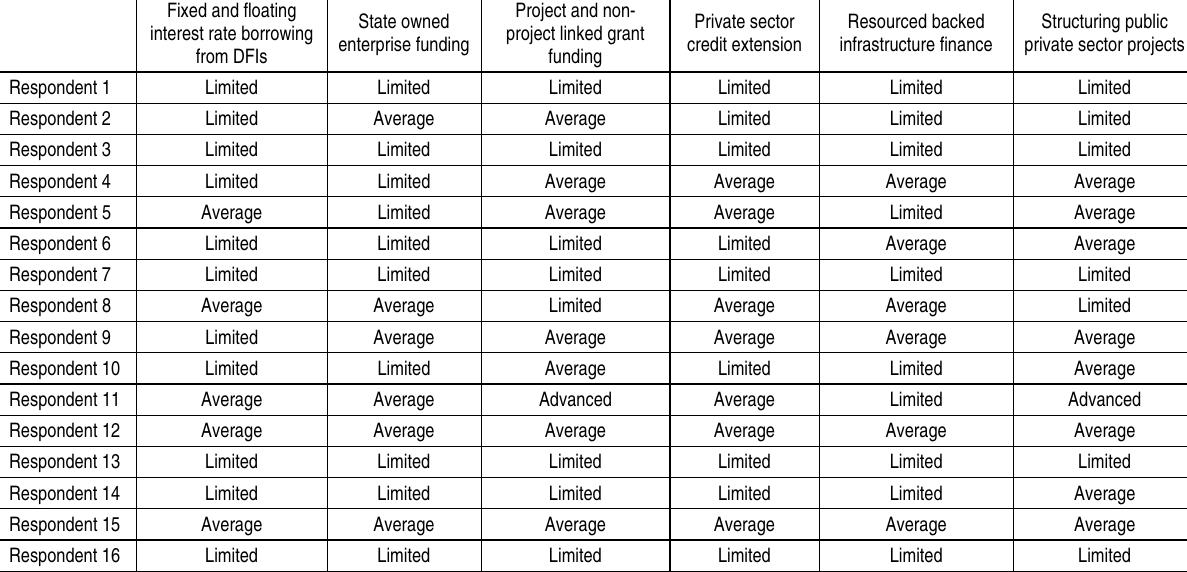
Table 2. Rating of working knowledge with finance